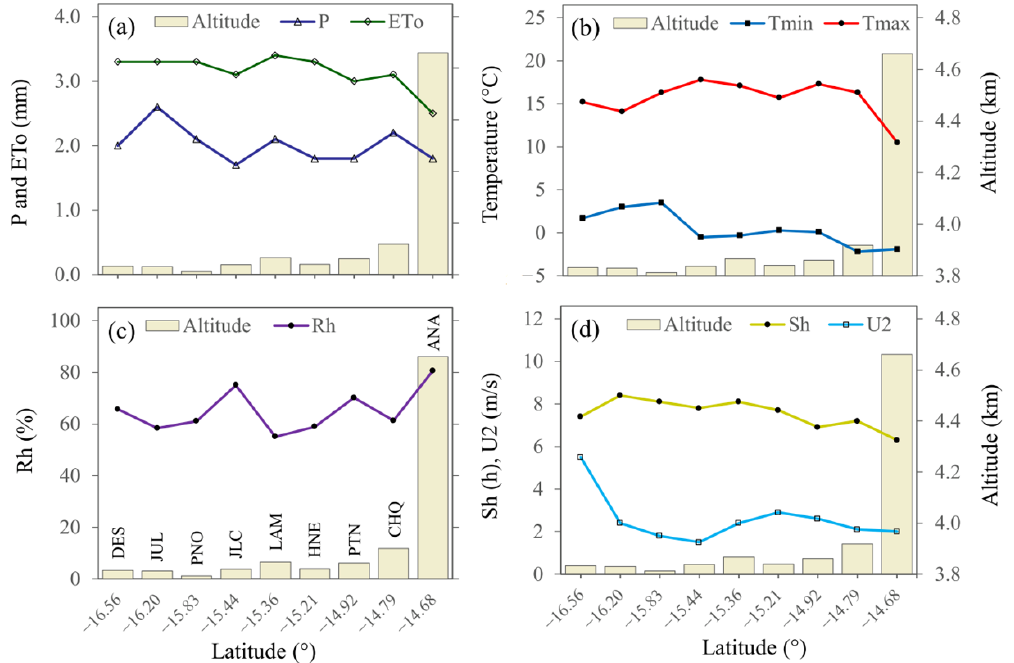
Figure 2. Variation of climatic factors as a function of latitude and altitude ( a ) P and ETo ( b ) Tmin and Tmax, ( c ) Rh and ( d ) Sh and U 2 .